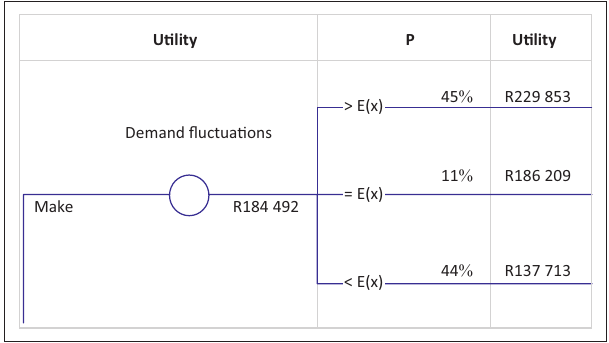
FIGURE 3: First uncertainty fork.